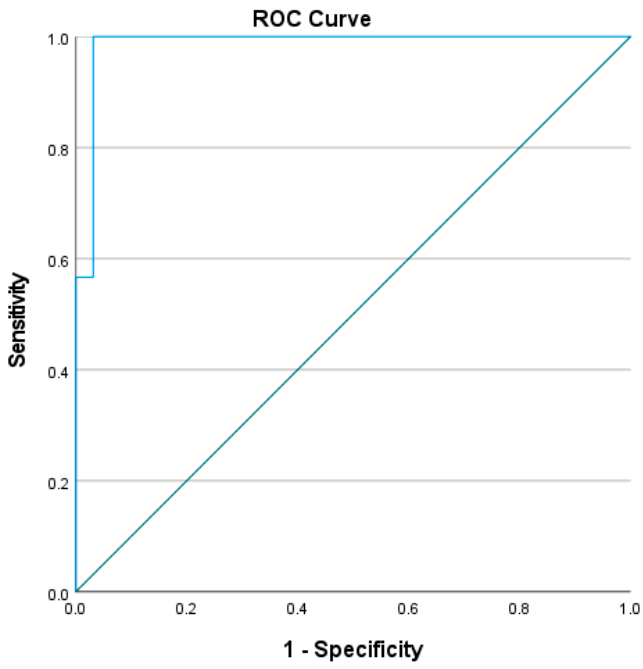
Figure 3. ROC curve of the L Test completion times involving turning towards the non-paretic side for the 90° and then turning towards the non-paretic side for the 180° (AUC = 98.6%, sensitivity = 100%, specificity = 96.9%, p < 0.001).